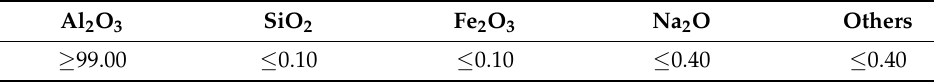
Table 1. The 99 alumina ceramic compositions.